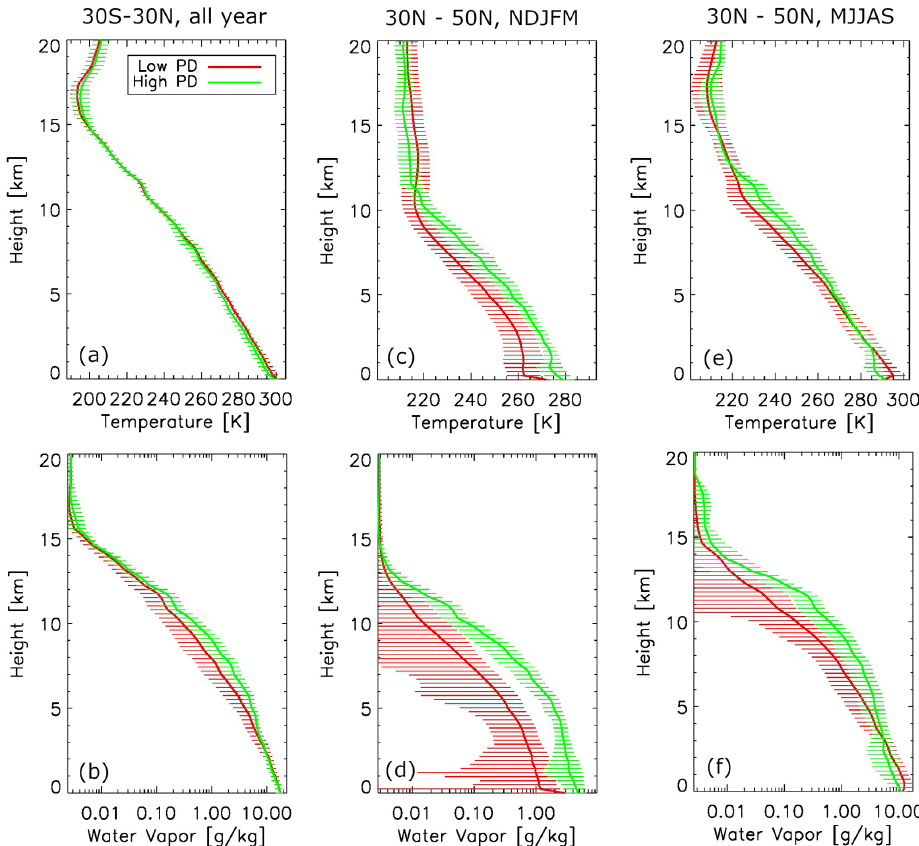
Figure 4. Temperature (a, c, e) and water vapor (b, d, f) profiles for high-PD (green) and low-PD (red) scenarios, respectively, for the tropics ( a, b , 30S–30 ◦ N) averaged over years, Northern Hemisphere extended winter ( c, d , 30–50 ◦ N, November–March) and Northern Hemisphere extended summer ( e, f , May–September). Error bars are also included in the same color for every other